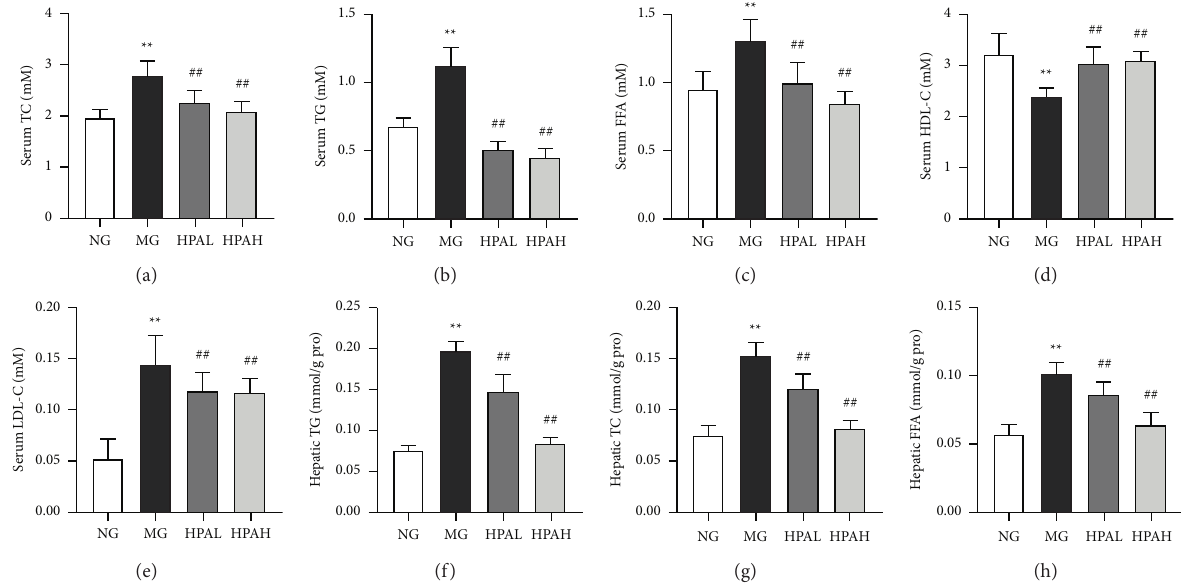
Figure 1: Effect of HPA on the serum and liver lipids in ALD mice. (a) Serum TG; (b) serum TC; (c) serum HDL-C; (d) serum LDL-C; (e) serum FFA; (f) hepatic TG; (g) hepatic TC; (h) hepatic FFA. Data were expressed as mean ± SD ( n � 12). ∗ ∗ p < 0 . 01, versus NG; # p < 0 . 05 and ## p < 0 . 01, versus MG.